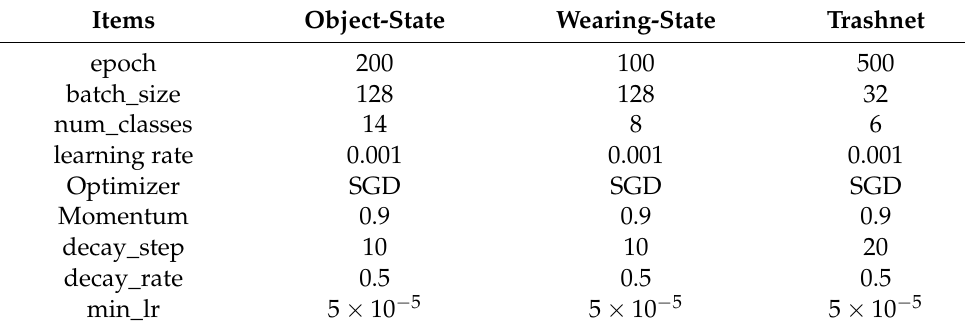
Table 3. Hyperparameters